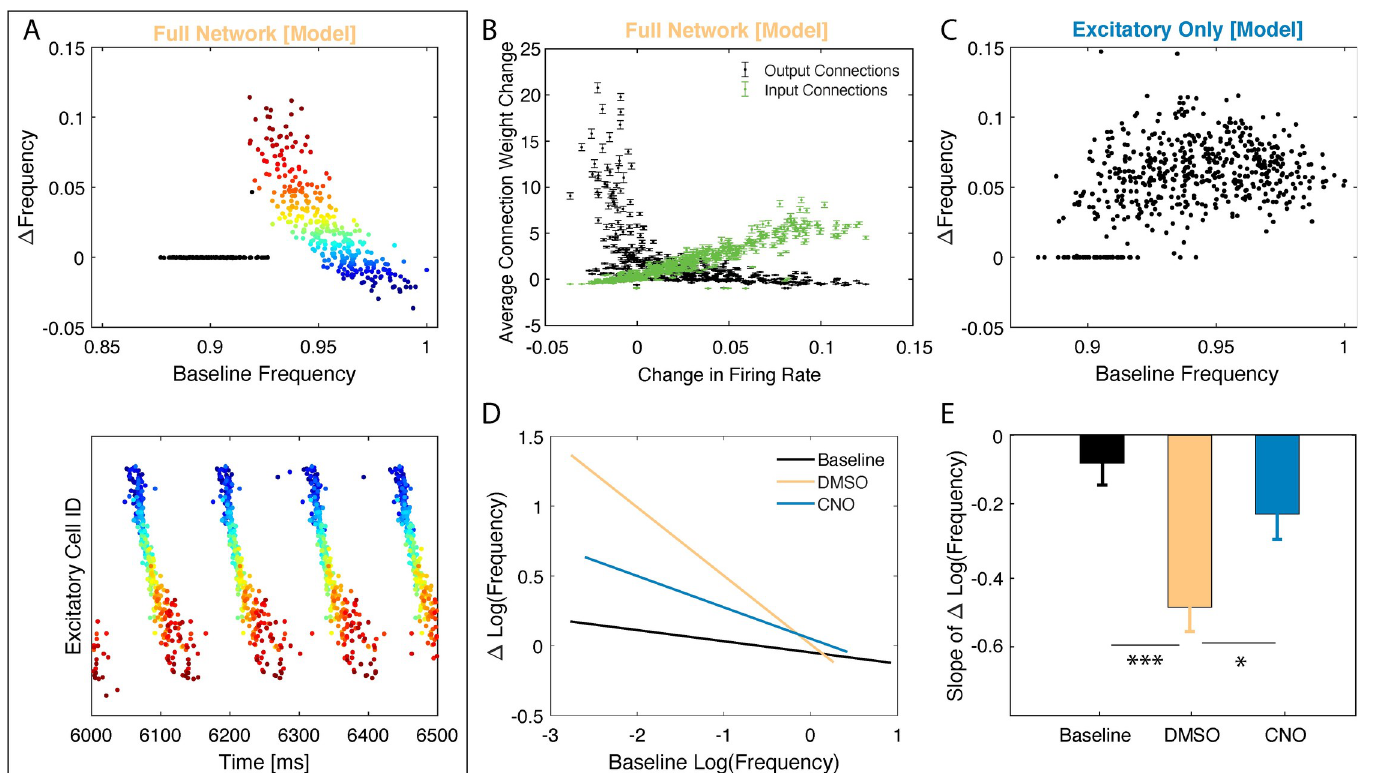
Fig 6. NREM dependent reorganization differentially affects frequency of firing neurons during wake-like dynamics–model prediction and experiment. SIMULATED DATA : A) Top: Changes in individual neurons’ firing frequency (normalized to baseline) observed during wake-like dynamics recorded across post- learning NREM sleep as a function of normalized baseline firing frequency (top). Conditions comparable to Fig 5D. Colors represent baseline frequency. Bottom: Snapshot of the corresponding raster plot in NREM sleep at the onset of consolidation. Neurons are color-coded based on their baseline frequency during wake like dynamics and the color is conserved in the raster plot. Black data points (top) are for neurons which did not fire during NREM sleep. Of the neurons that are consistently active, those with initially lower frequency increase their frequency whereas neurons with initially higher frequency decrease their frequency. B) Average connection weight change for a given neuron vs its frequency change during wake-like dynamics, observed in A. Neurons that increase their firing rate do so due to increased synaptic input, at the same time their mean strength of output connections decreases. C) Change in firing frequency (normalized to baseline) as a function of normalized baseline firing frequency in the absence of inhibition. Conditions comparable to Fig 5A. Unlike the full-network condition (with inhibition), firing frequency changes homogenously across baseline firing rates. EXPERIMENTAL DATA : D) Best fit lines of the change in log firing rates vs the initial log firing rate, comparing baseline recordings (solid lines; composite n = 11) to post recordings (dashed lines) for the first 6 hours post CFC for mice expressing the inhibitory DREADD hM4Di in PV + interneurons, treated with either DMSO (Yellow; n = 3; analogous to the full model network) or CNO (Teal; n = 3; analogous to reduced network inhibition), and wild type mice with post-CFC SD (Blue; n = 5). E) Slope comparison of change in log firing rates for DMSO, CNO, and SD baseline and post-CFC recordings. Analysis of covariation revealed statistically significant slope differences between DMSO and CNO ( � indicates p < 0.05), and DMSO and Baseline ( ��� indicates p <